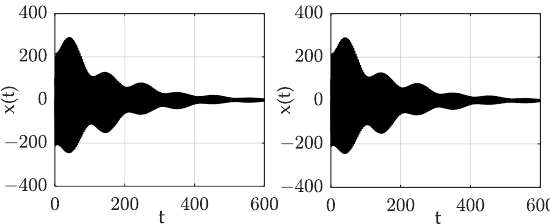
Figure 4. Response of point B, with F=0 ( left ) and F=1 ( right ). Figure 5. Response of point C, with F=0 ( left ) and F=1 ( right ).